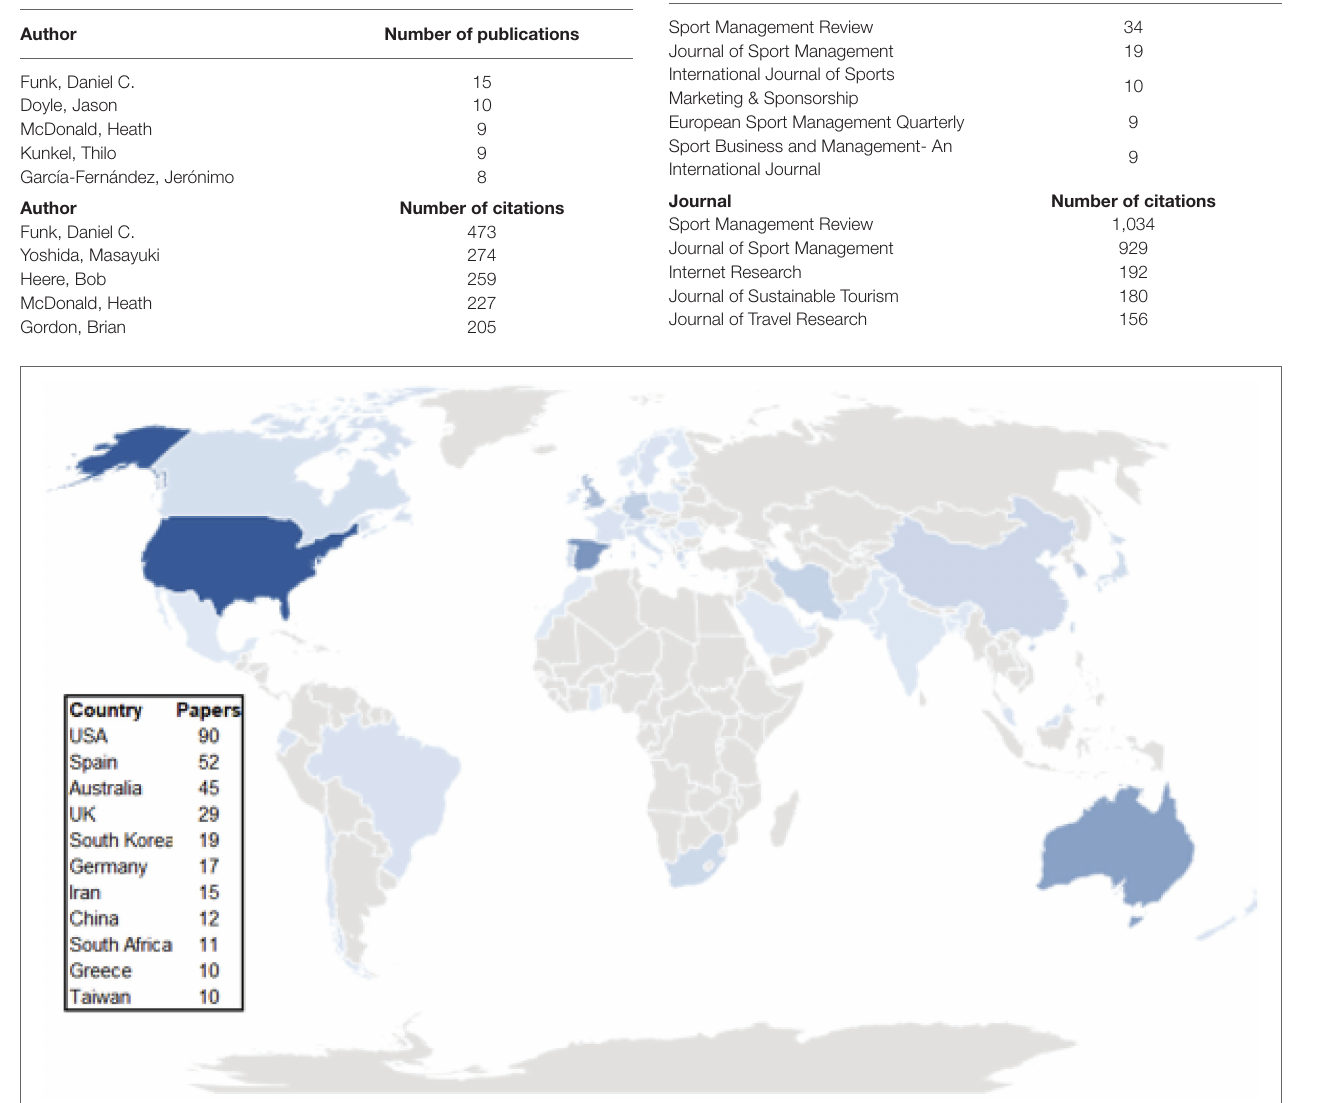
TABLE 6 | Number of papers and citations per